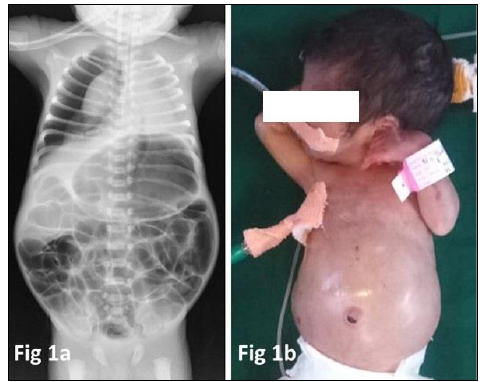
Fig.1a. Right pneumothorax with grossly distended stomach with splinting of diaphragm and Fig.2b. Intu- bated neonate with grossly dilated stomach and Rt ICD .